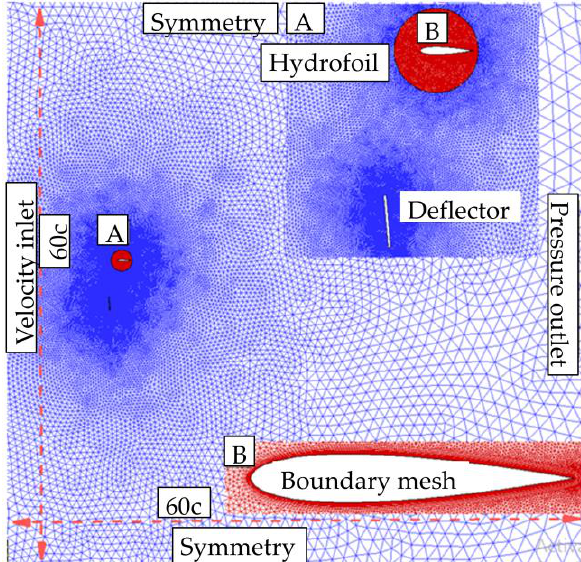
Figure 2. Computational domain, mesh distribution, and boundary conditions for a two-dimensional oscillating hydrofoil turbine with a single upstream deflector. Total cell count: 95,000 (360 on the hydrofoil). Table 1. Comparison of time average force and power coefficients for different mesh sizes and time-step sizes (number of cells ( N cell ) was